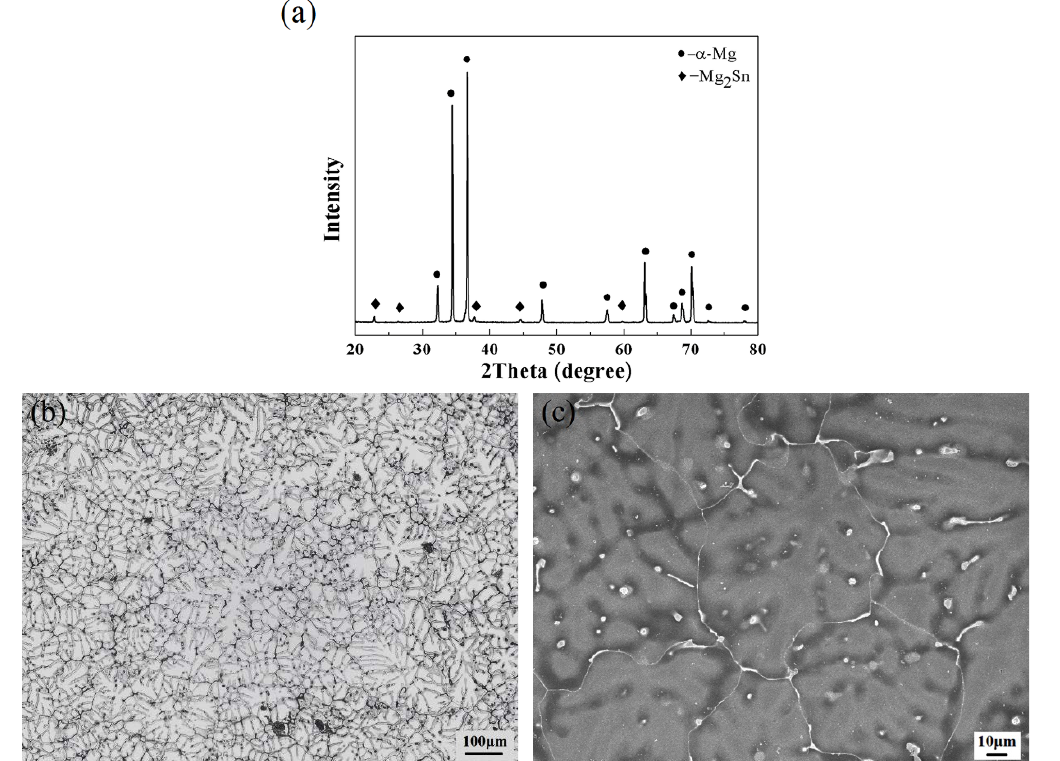
Figure 2. XRD analysis result and microstructure of the as-cast Mg–6Sn–2Zn alloy, which was used as the base metal (BM) in this study: ( a ) XRD analysis result; ( b ) optical microstructure; and ( c ) SEM image.